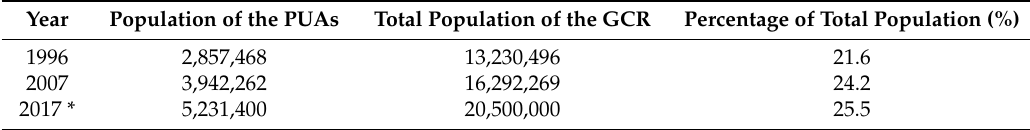
Table 1. Peri ‐ urban areas share of Greater Cairo’s population. Table 1. Peri-urban areas share of Greater Cairo’s population.